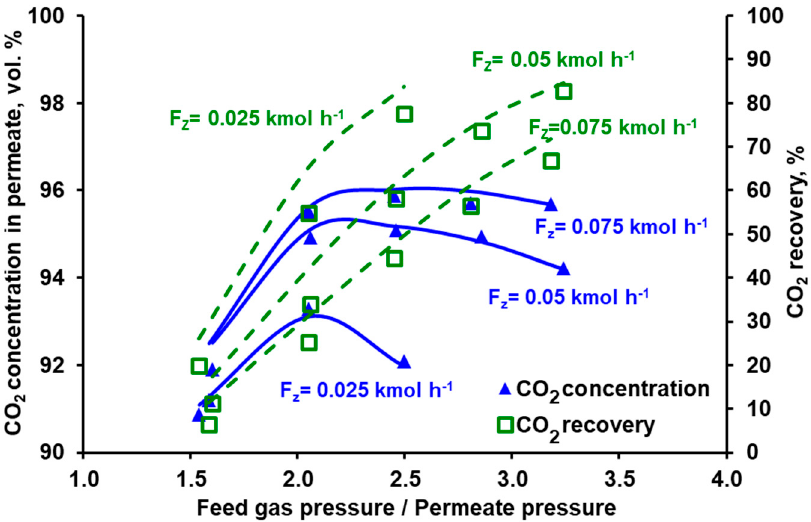
Figure 7. Experimental (points) and theoretical (lines) CO 2 purity and recovery in Air Products PRISM PA1020 module against feed to permeate pressure ratio for various feed gas flow rates. Inlet CO 2 concentration: 70 vol.%, temperature: 293 K. Standard deviation; purity = ± 0.4, recovery = ± 0.1.